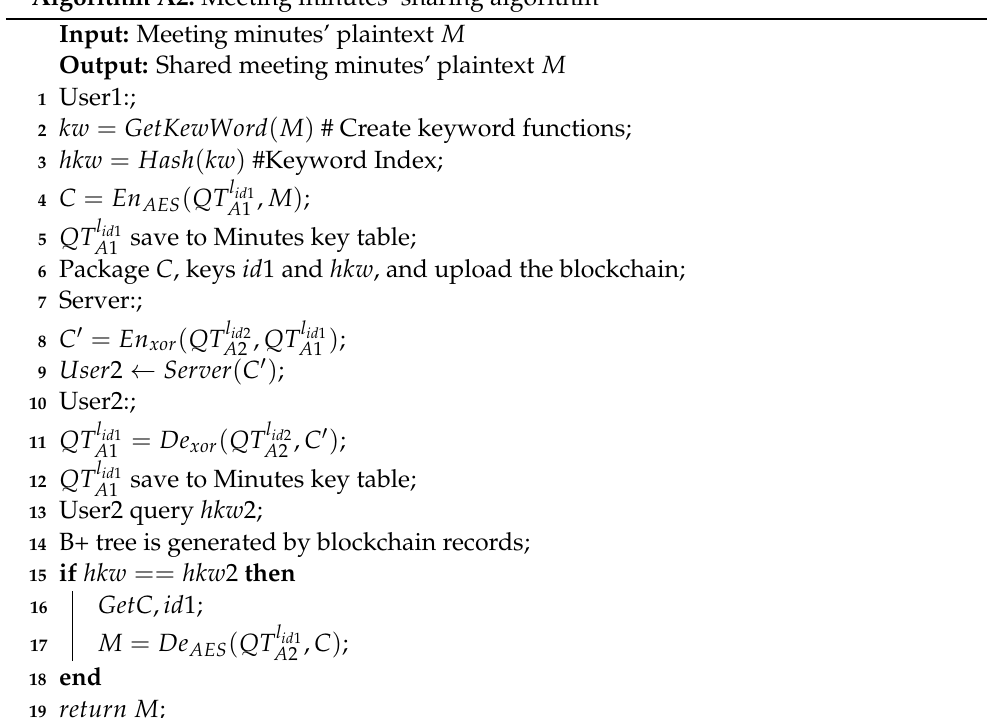
Algorithm A2: Meeting minutes’ sharing